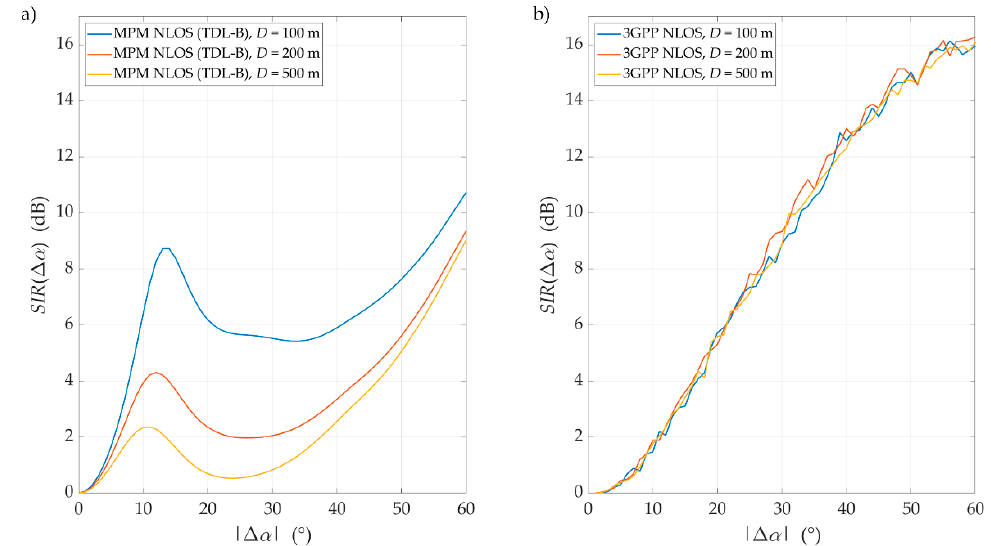
Figure 9. SIRs versus angle of beam separation for non-line-of-sight (NLOS) conditions and different distances between UE and gNodeB obtained for the ( a ) MPM and ( b ) 3GPP model.